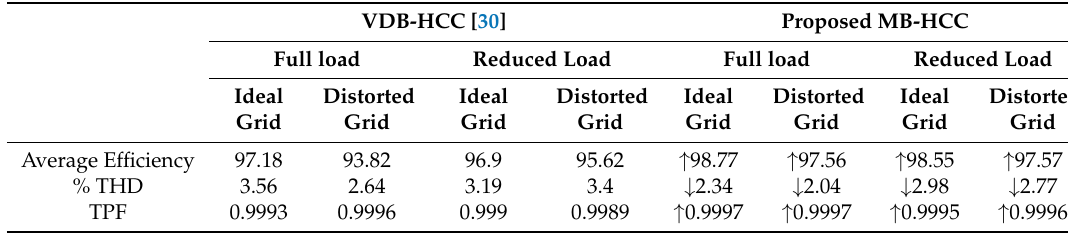
Table 7. RT results summary.